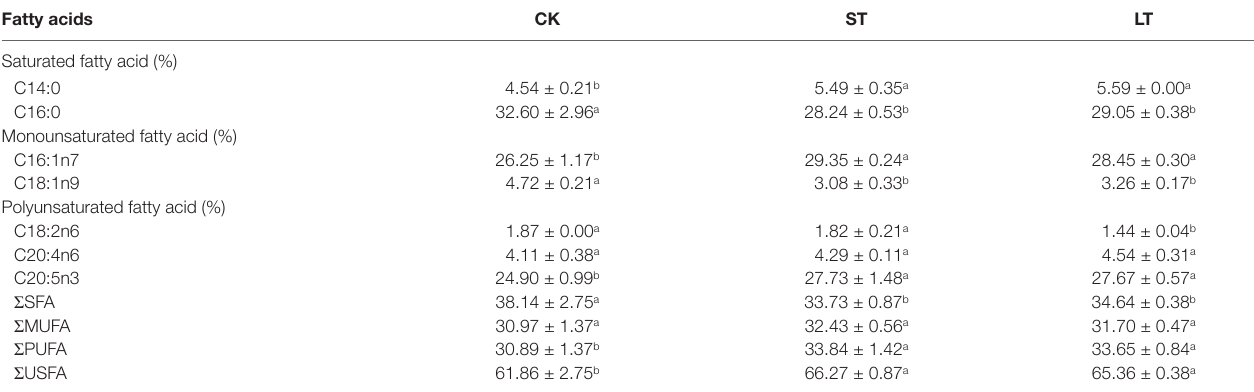
TABLE 3 | Fatty acid composition (%) of N. oceanica when subjected to different treatments.